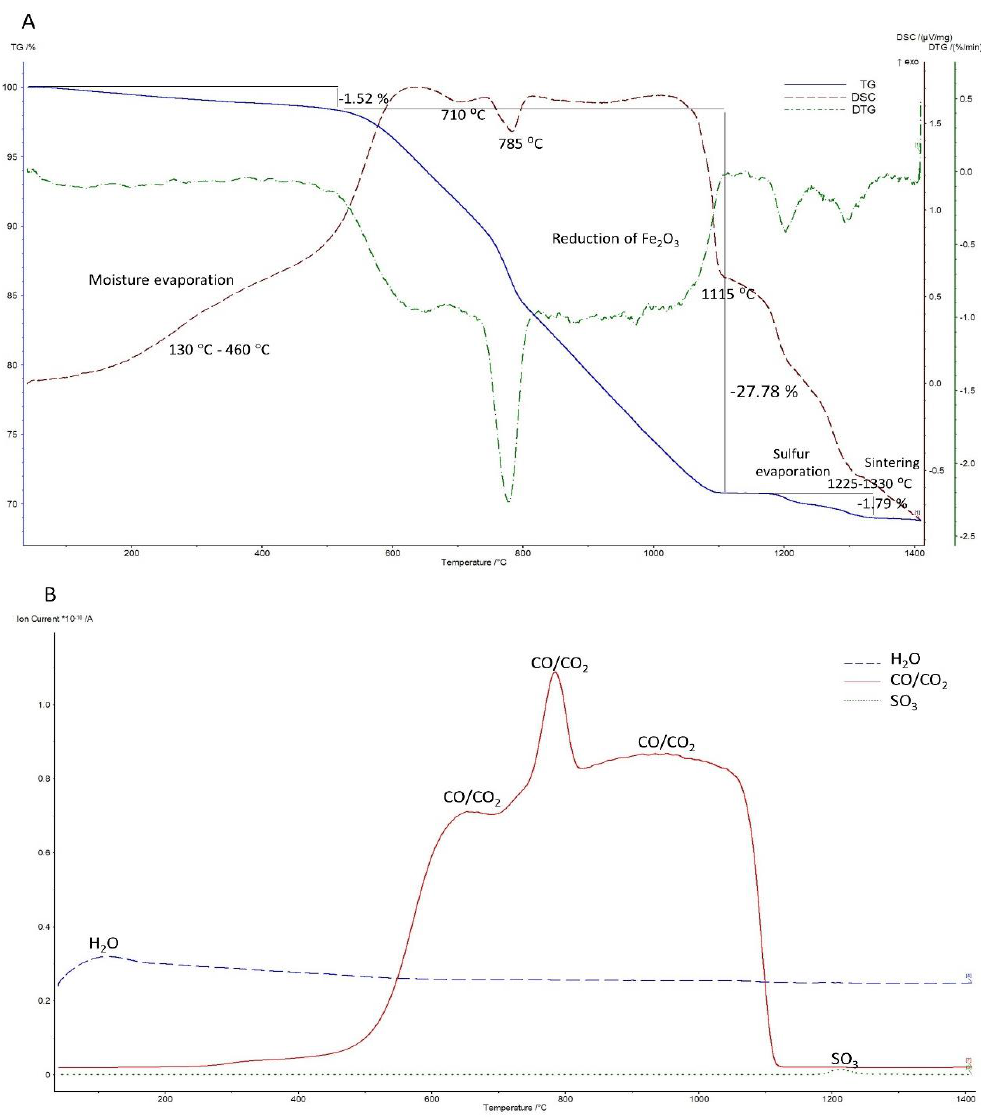
Figure 4. Thermal analysis of BF sludge under argon atmosphere: ( A ) TG / DTA / DTG; ( B ) Mass spectroscopy.